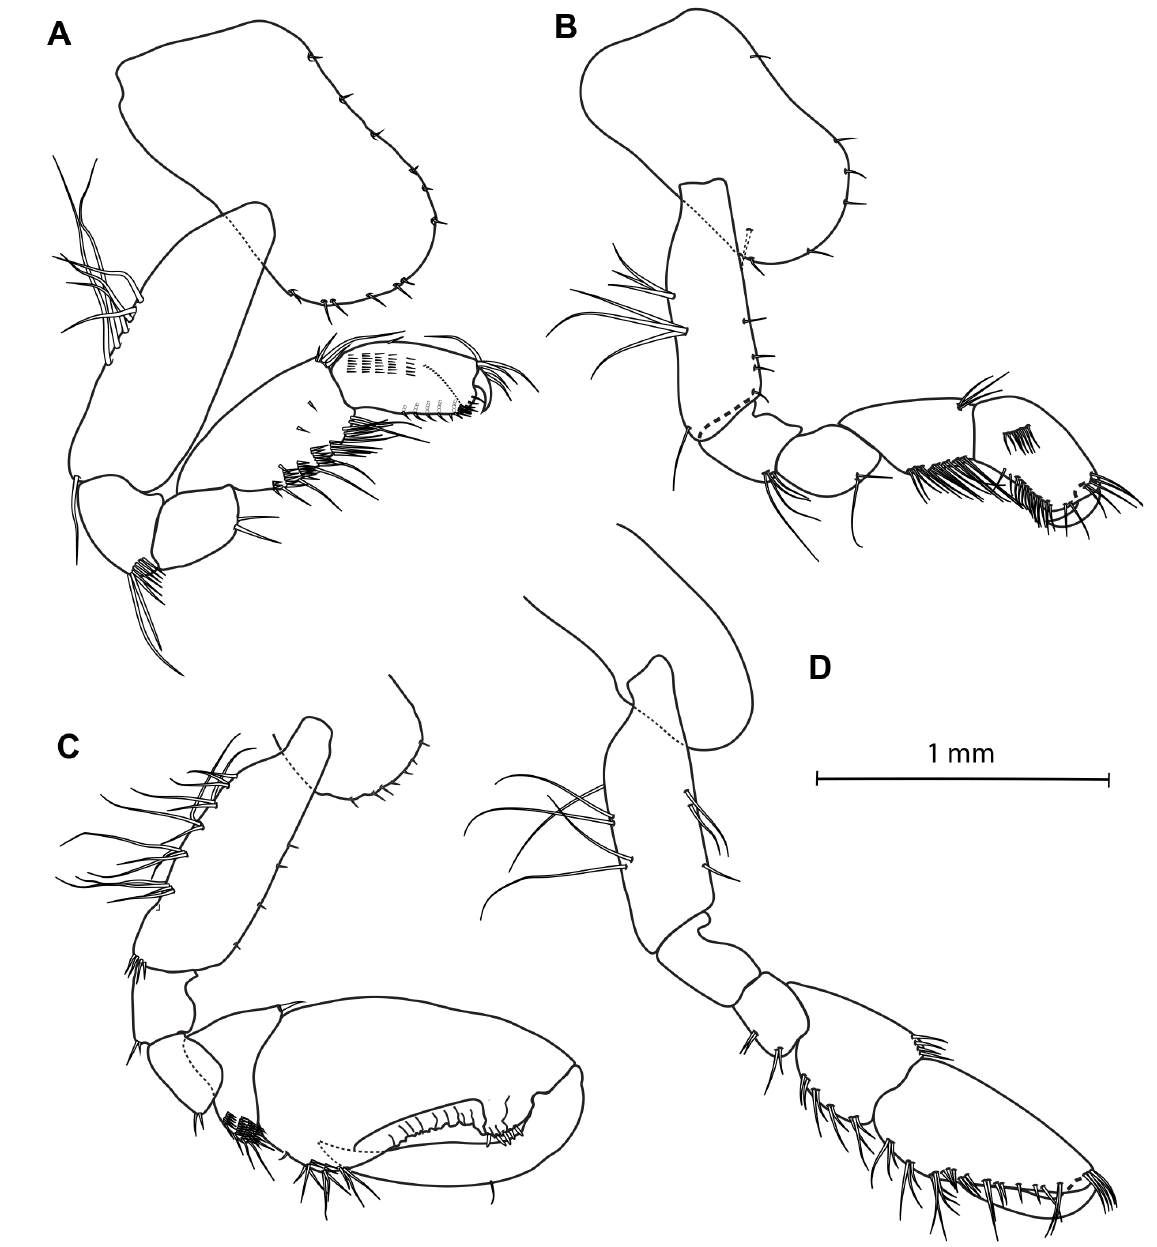
Fig. 3. Quadrivisio laleyei sp. nov. A ., C . Holotype, ♂, 7.5 mm, MNHN IU-2017-209, gnathopod. B ., D . Paratype, ♀, 7.0 mm, MNHN IU-2017-211,